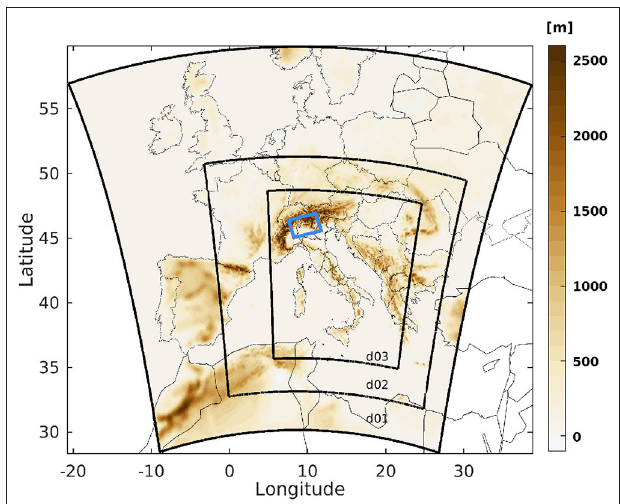
FIGURE 3 | WRF model orography with the outline of the three numerical domains. From the outermost domain (d01) to the innermost one (d03) the grid spacing is 13.5, 4.5, and 1.5 km. The small light blue rectangle indicates the area covered by the SAR